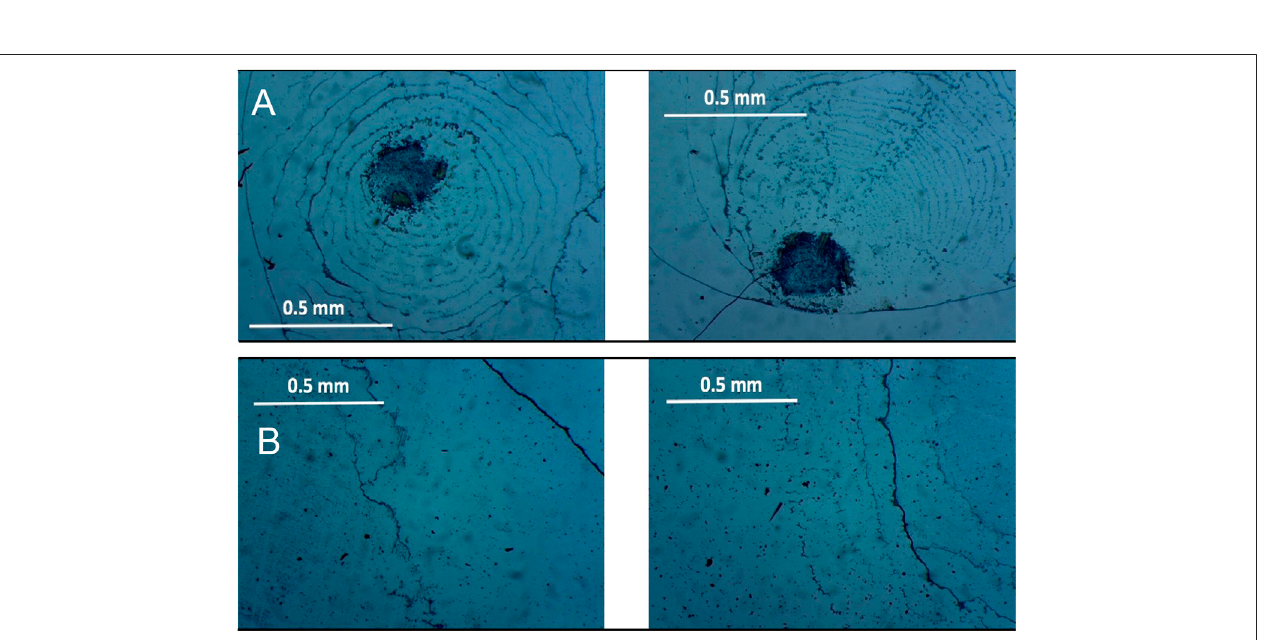
Frontiers in Physics |